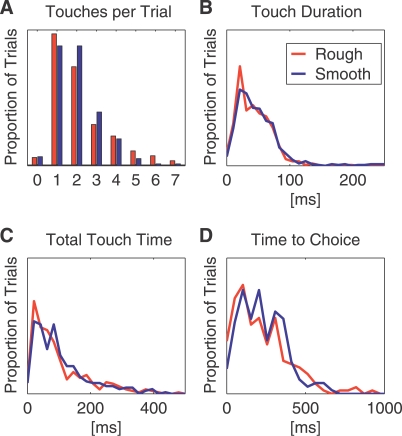
Whisker Touch StatisticsFor the whiskers of interest, contact onset and offset times were measured for all touches ending prior to the moment of choice.(A) Number of touches per trial per whisker (red—rough texture; blue—smooth texture)(B) Individual touch durations.(C) Summated duration of all touches of a single whisker per trial.(D) Time from first contact of the whisker of interest to the rat's choice. Values are consistent with a reported range of 150 to 500 ms in a different texture discrimination task [34].